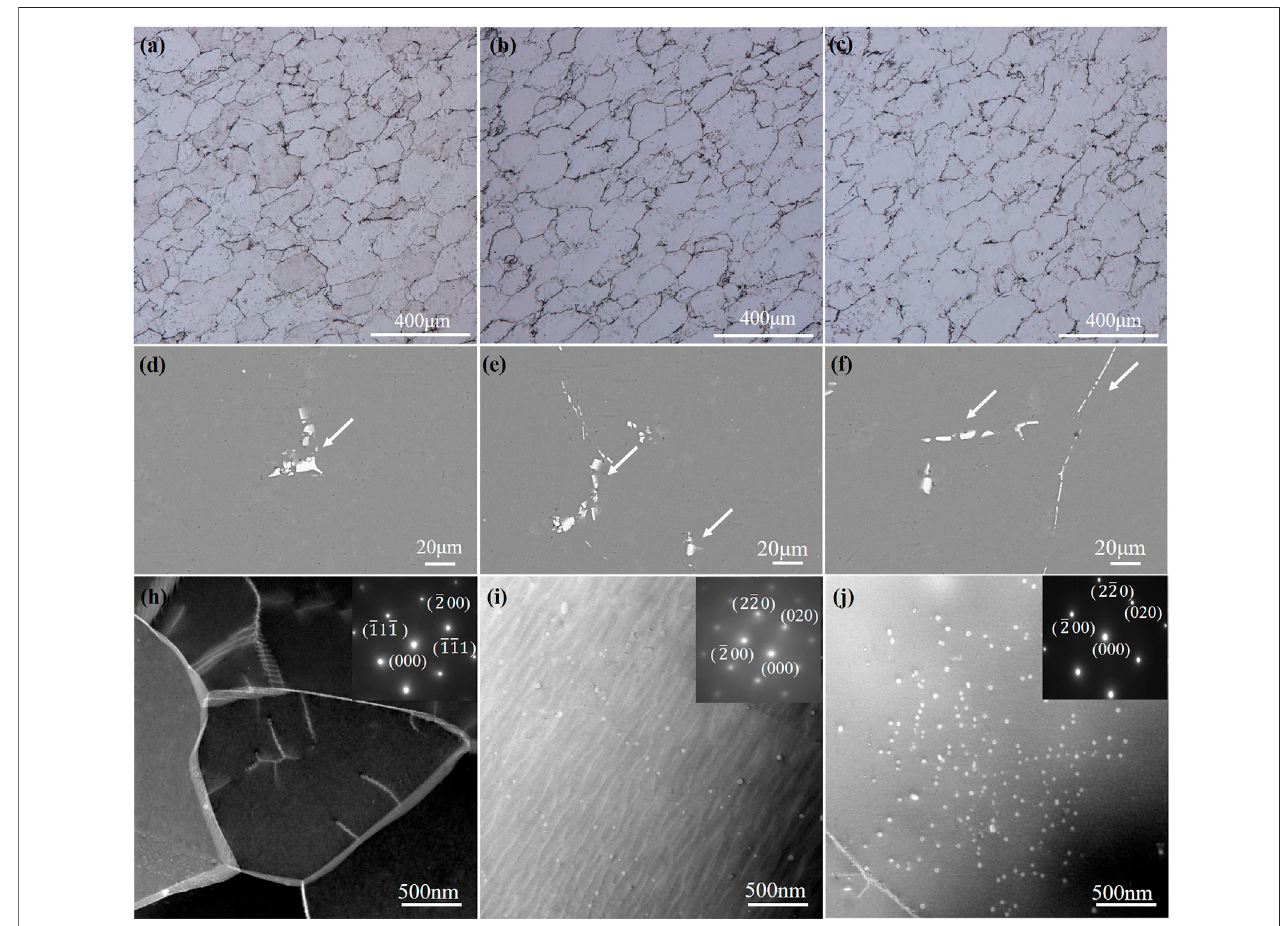
FIGURE 1 | Microstructure of CSE forming blank. (A,D,H) 1#, (B,E,I) 2#, (C,F,J) 3#.